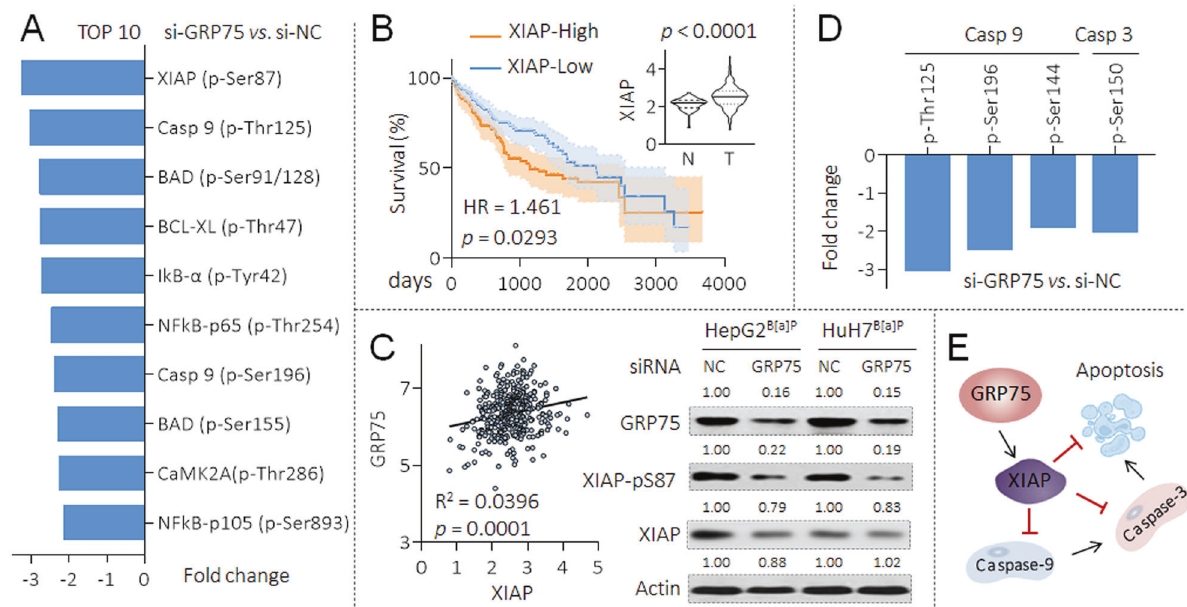
Fig. 5 Potential mechanisms of GRP75 in B[a]P-induced MDR in HCC cells. A The top 10 proteins with the most signi fi cant phosphorylation changes in the phospho antibody array, the data of each phosphorylation site levels exhibited was the mean of two biological replicates. B Expression levels in tumor/para-cancerous tissues and prognostic signi fi cance of XIAP protein based on the TCGA. ( C , left) The correlation analysis between GRP75 and XIAP based on TCGA. ( C , right) After the transfection with si-NC or si-GRP75, western blot analysis of the expressions of GRP75, XIAP(p-S87), and XIAP. D The phosphorylation levels of caspase-9 and caspase-3 with different sites in the phospho array. E A mechanism map speculating the potential mechanisms involved in GRP75-induced